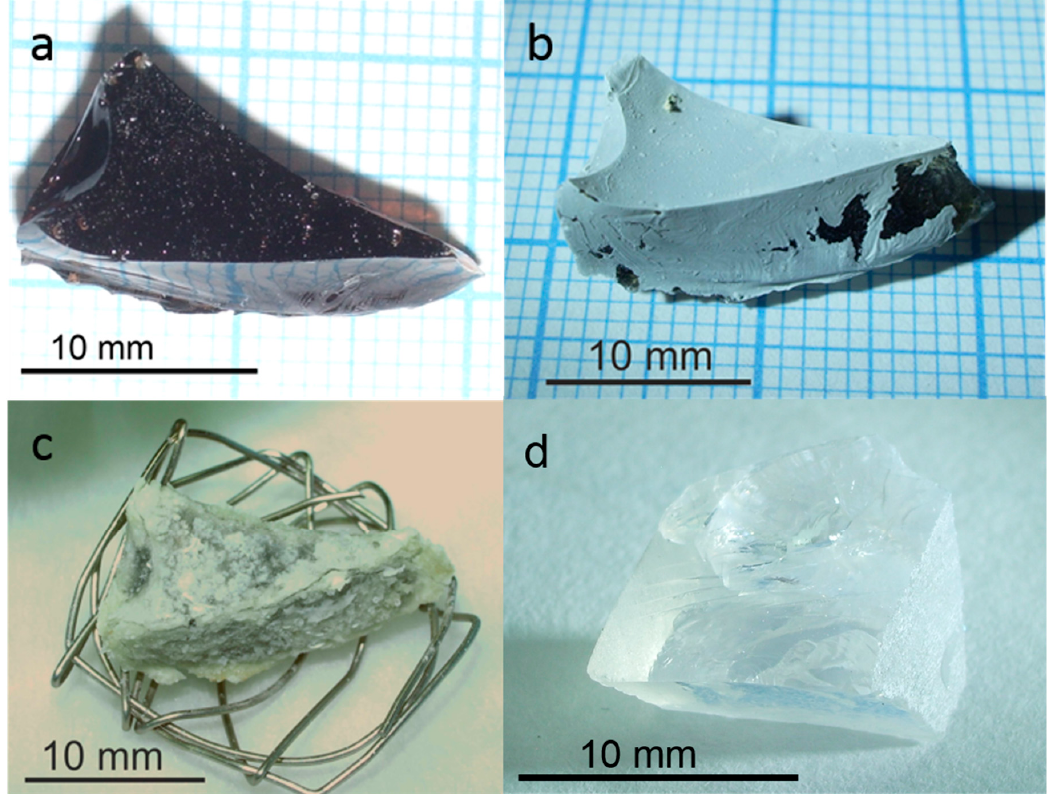
Figure 6. ( a – c )—sample of borosilicate glass «B ‐ Si_238» doped with 0.45 wt.% 238 Pu: ( a )—pristine sample—the fragment extracted from the broken crucible right after synthesis; ( b )—glass sample after 4 months in contact with distilled water at 90 °C; ( c )—glass sample after 2 years of storage in the wet container at 90 °C on a Pt ‐ wire support; ( d )—non ‐ radioactive «B ‐ Si» glass sample after 4 months in contact with distilled water at 90 °C.